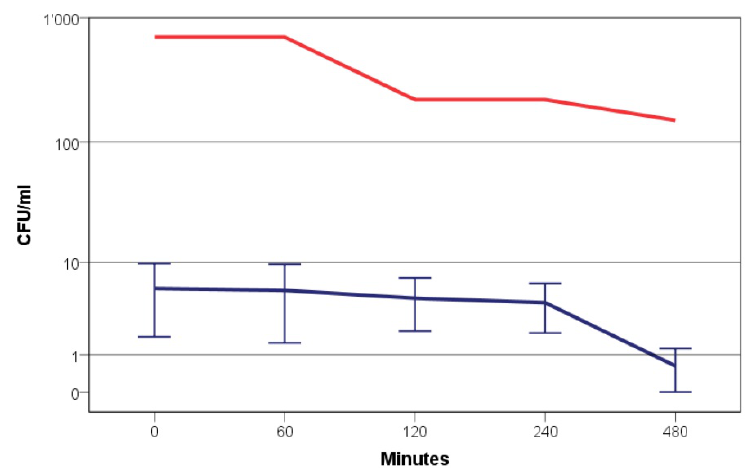
Figure 3: Bacterial regrowth on washed scaffolds ( P. acnes , Copal G+C, blue line, 95% confidence intervals) and positive control (red